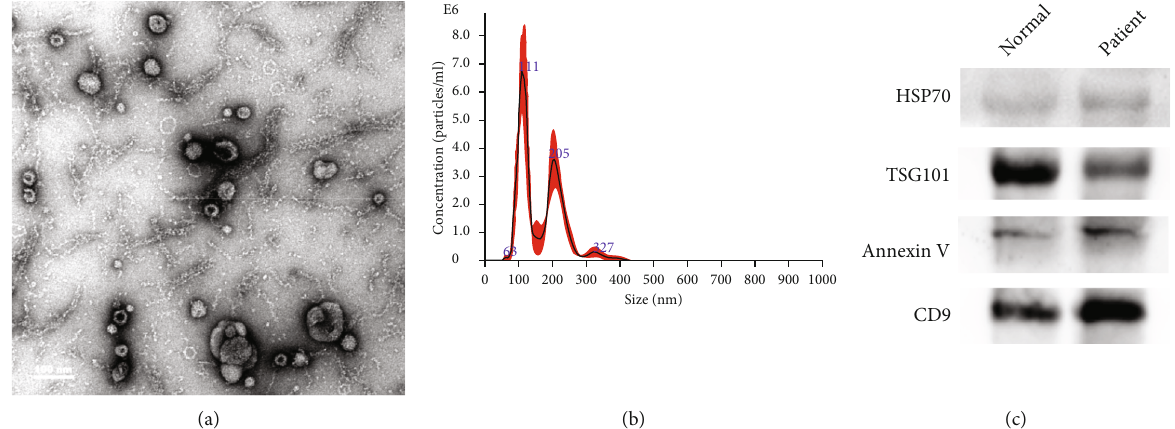
Figure 1: Characterization of urinary exosomes. (a) Transmission electron microscopy image of exosomes isolated from urine; scale bar: 100nm. (b) Particles were observed in the size range of 50 to 200 nm by nanoparticle tracking analysis. (c) Western blot analysis of the exosomal protein markers HSP70, TSG101, Annexin V, and CD9. Exosomes were derived from healthy controls and bladder urothelial carcinoma